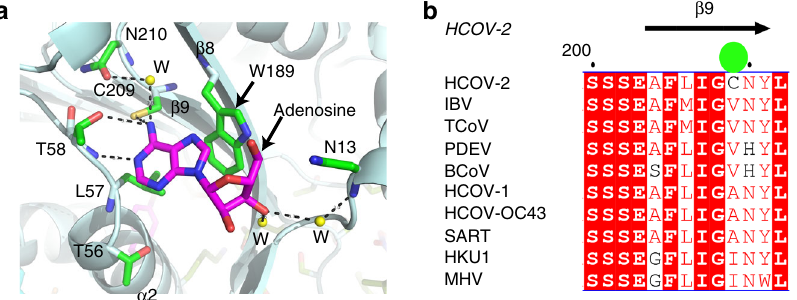
Fig. 3 Alternative ligand-binding site in nsp16. a nsp16 residues that participate in adenosine (magenta stick) binding are shown as green sticks; water molecules are shown as yellow spheres. b Cys209 (green sphere) in the β 9 strand, which is present in nsp16 of SARS-CoV-2, but no other CoV